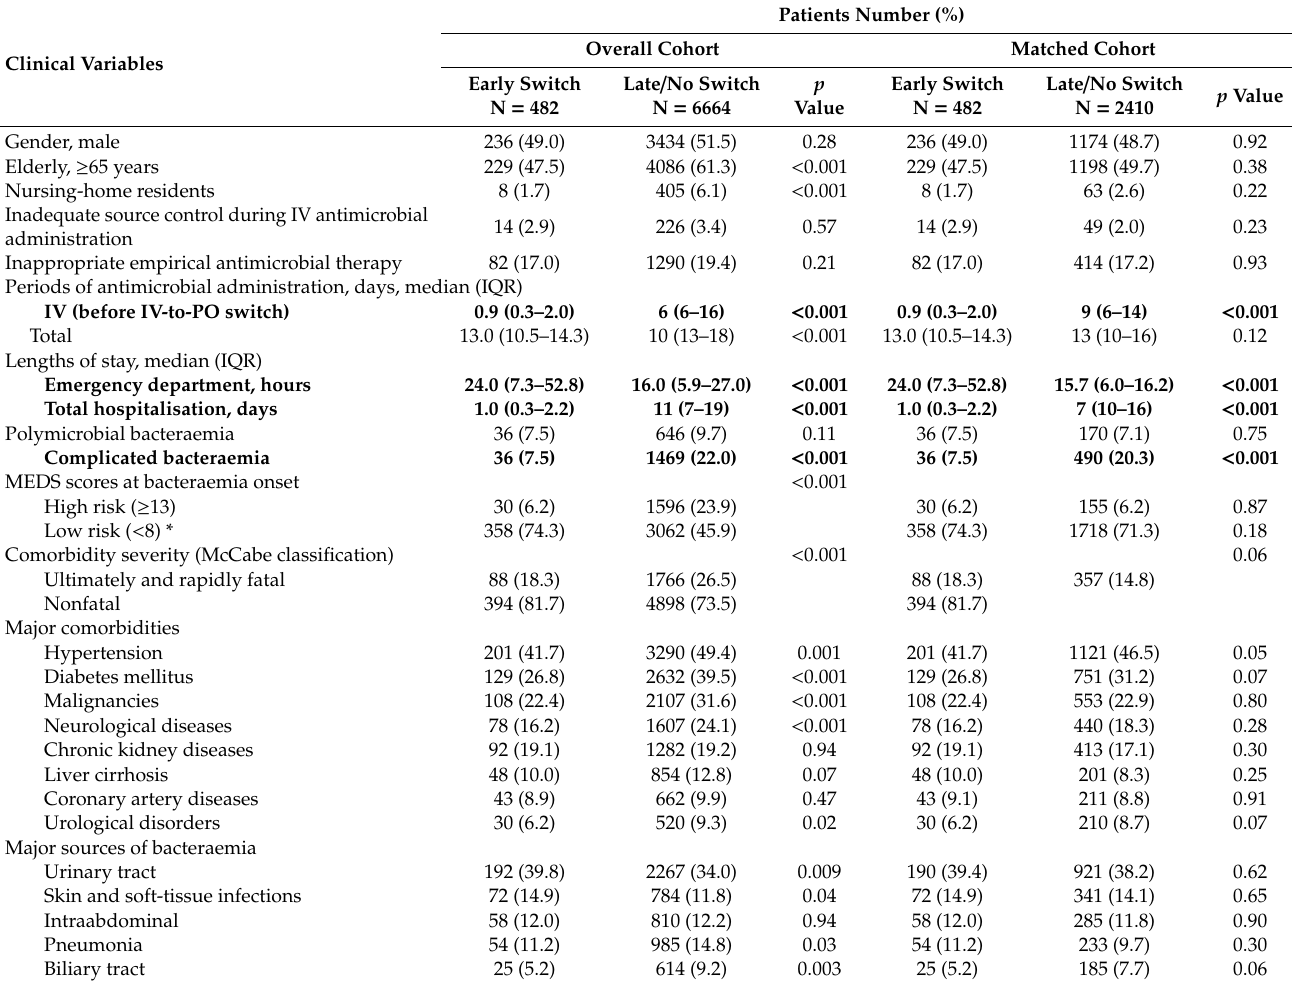
Table 1. Clinical characteristics and mortality rates of the early and late / no IV-to-PO switch patients in the overall and matched cohorts *.